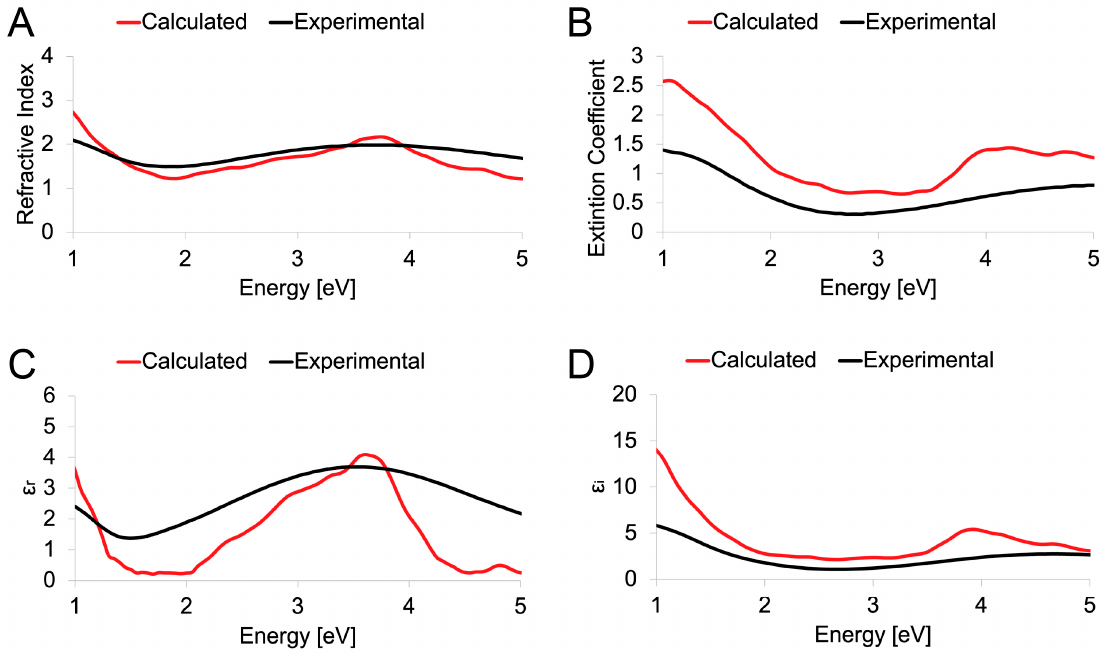
Figure 6. Calculated (red) and experimental (black) optical spectra of monoclinic MoO 2 . Refractive index ( A ), extinction coefficient ( B ), real part ε r ( C ), and imaginary part ε i ( D ) of the dielectric constant reported as a function of the energy.